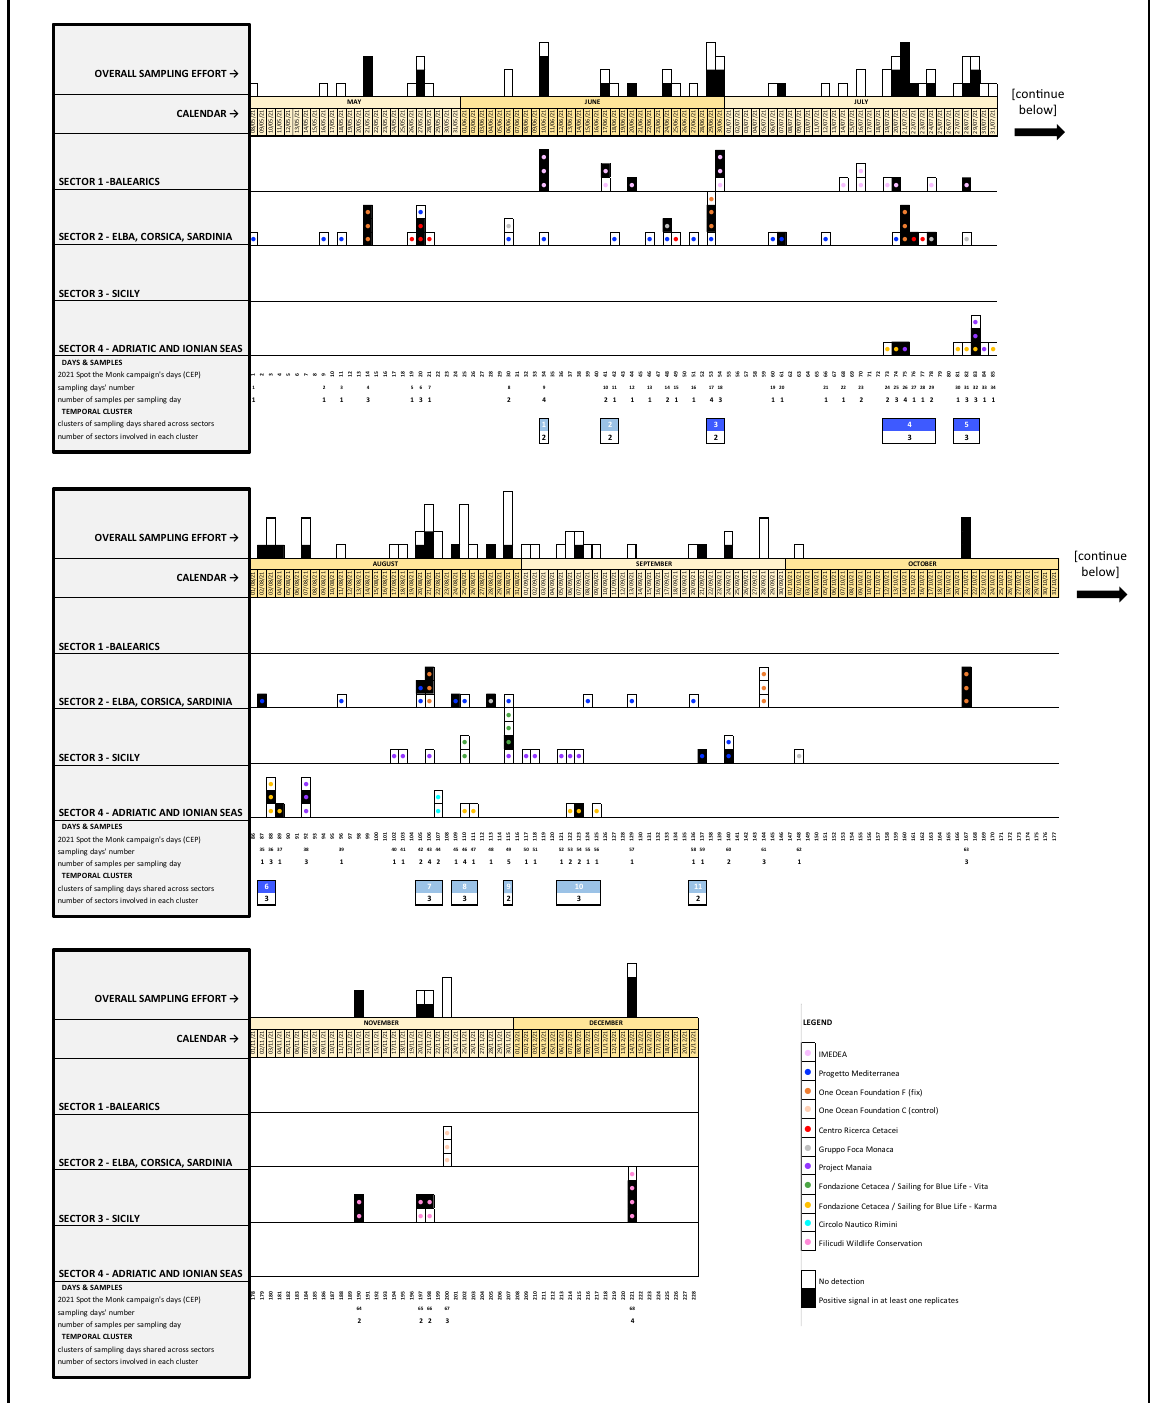
Figure 3. Calendar showing the chronological distribution of the samples (n = 126) collected during the Core Effort Period (CEP, from 08/05/21 to 14/12/21) both in the 4 sectors and overall (below and above the calendar bar respectively). The 8-months period has been split into 3 parts to enhance readability. Temporal-clusters, i.e. days or groups of days in which water samples were taken simultaneously in different sectors, are highlighted in the lower portion of each calendar row (blue boxes)—these were all concentrated between June and September, when the joint effort of several CS operators was highest. The number in the white part of each temporal-cluster box indicates the number of sectors simultaneously sampled. Temporal-clusters marked with darker blue (#3, #4, #5 and #6) are those in which samples were found positive in two or three sectors